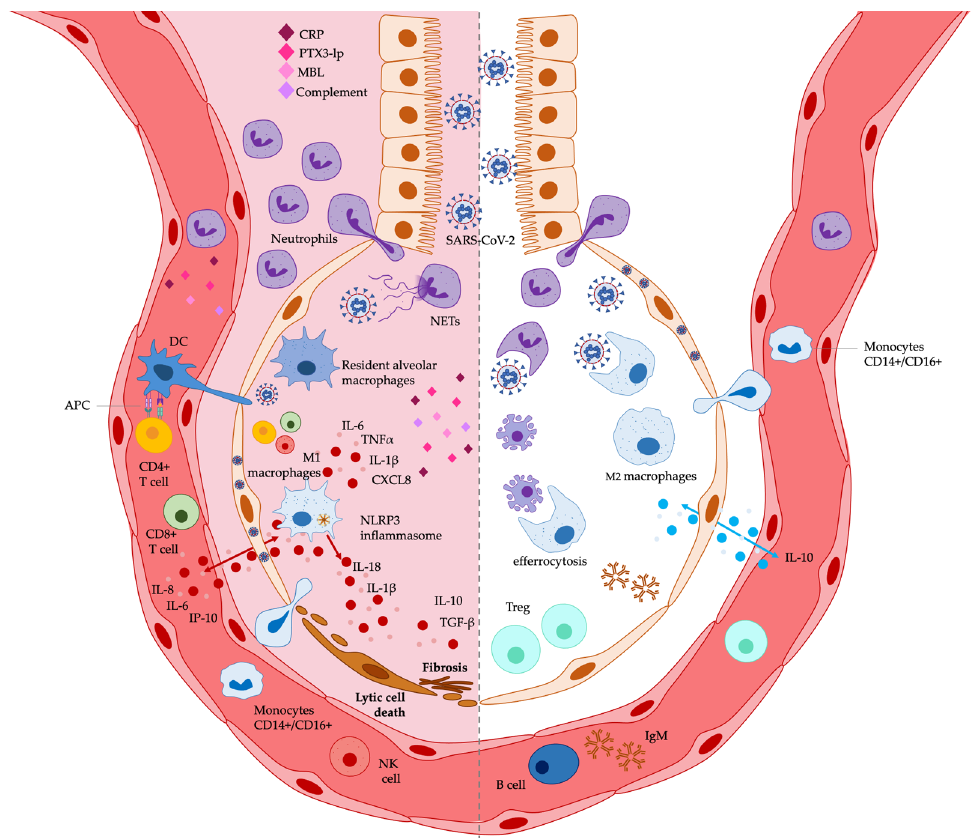
Figure 1. Potential effects exerted by n-3 PUFAs on lung immunological markers associated with COVID-19 related ARDS. The immunological biomarkers potentially decreased by n-3 PUFAs are shown on the left, while those potentially increased are shown on the right. See Table 4 and the text for a detailed description. APC: antigen presenting cell; CRP: C-reactive protein; DCs: dendritic cells; IgM: immunoglobulin M; IL-: interleukin-; IP-10: IFN- γ -inducible protein 10; MBL: man- nose-binding lectin; NET: neutrophil extracellular trap; NK: natural killer; NLRP3: NOD-, LRR- and pyrin domain-containing protein 3; PTX3-lp: long-pentraxin 3; Treg: regulatory T cells.